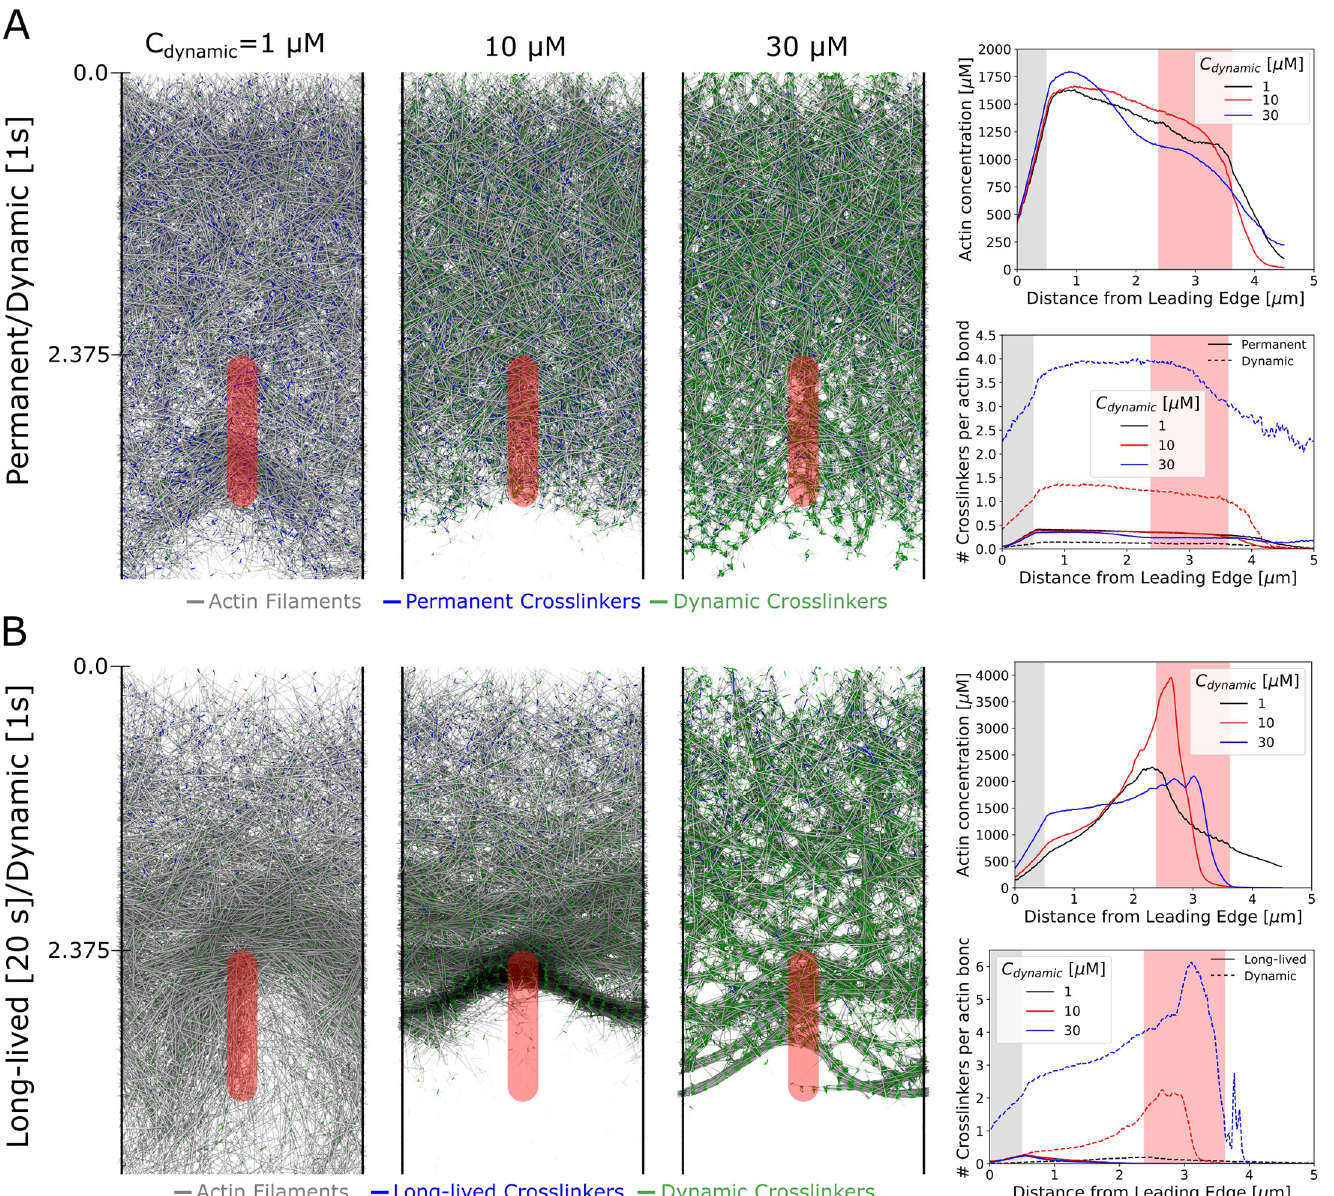
Fig 6. Actin bundle arc formation at the lamellipodium boundary. Filament rearrangement leading to bundling of the actin filaments in the focal adhesion region can occur but only if the restrictions due to the permanent crosslinkers are relieved over time. A mature focal adhesion at the back of the lamellipodium is simulated by starting the focal adhesion region at y = 2.375 μm and using a focal adhesion strength κ FA = 250. For these simulations we used the uniform pulling mechanism. (A) Snapshots (left) and concentration profiles (right) by a combination of permanent and dynamics crosslinkers. Increasing the number of dynamic crosslinkers results in tighter bundles of filaments while leaving the overall spatial concentration of filaments relatively unchanged and there is no bundling of filaments near the focal adhesion region. Blue (green) line segments represent permanent (dynamic) crosslinkers. (B) Same as panel A but replacing permanent crosslinkers with crosslinkers that have a finite lifetime of 20 s . Bundling, together with a peak in actin concentration, occurs in front of the focal adhesion region at intermediate dynamic crosslinker concentrations. In the simulation snapshots, the scale along the vertical ( y ) axis is in μm . Blue (green) line segments represent long-lived (dynamic) crosslinkers. All data calculated from simulations equilibrated for at least 140 s and averaged over at least 35 s.